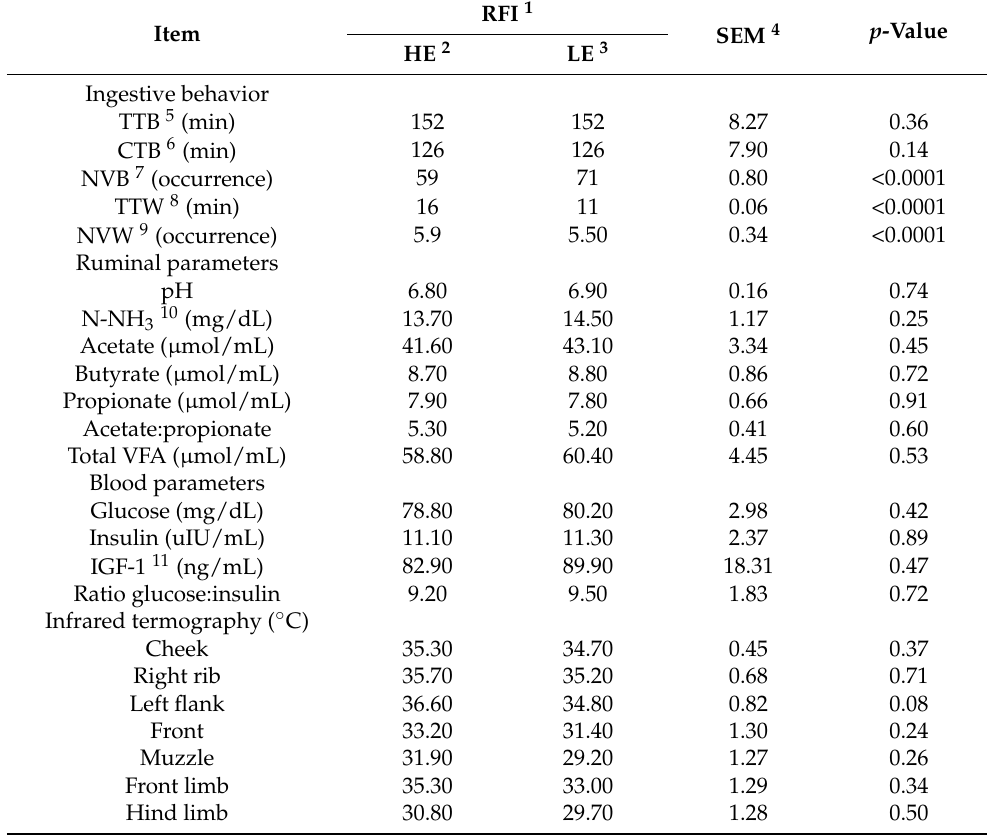
RFI 1 SEM 4 LE 3